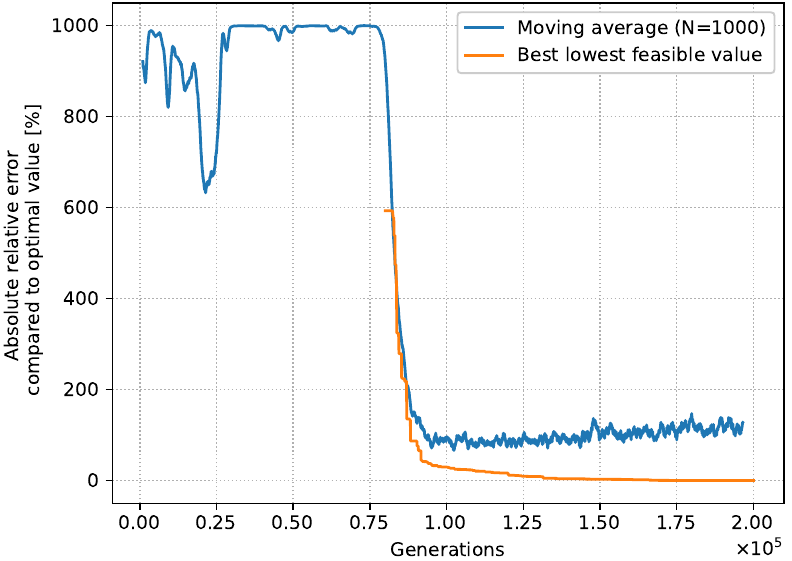
Figure 16. Convergence plot with moving average and lowest absolute relative